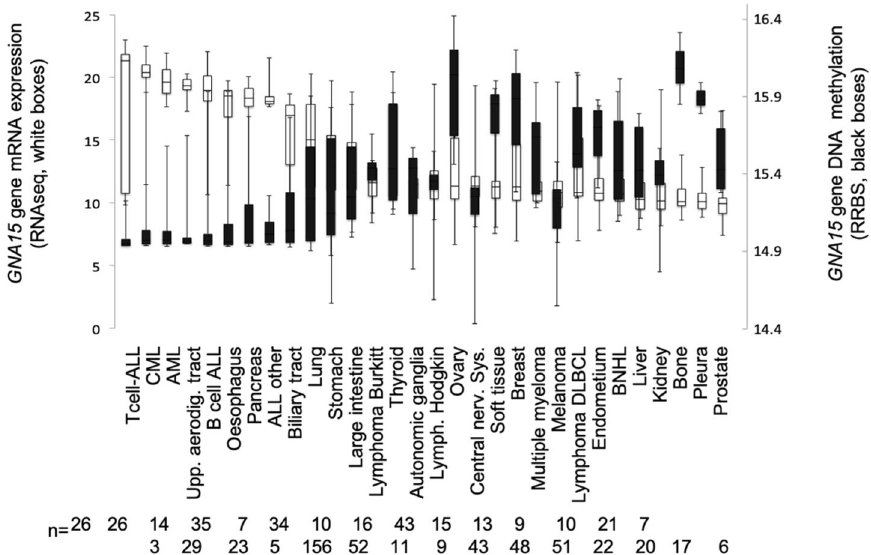
Figure 2. GNA15 expression and methylation in cancer cell lines. GNA15 mRNA expression (white bar showing RNAseq on the left axis) and DNA methylation (black bars, showing reduced representation bisulfite sequencing (RRBS) on the right axis) according to data from the Cancer Cell Encyclopedia. Among one thousand cancer cell lines, pancreas and biliary tract are the only normal tissues that do not express GNA15 but the derived cancer cell lines had high GNA15 expression levels, comparable to leukemia and upper aero- digestive tract. Box plots are shown as median and 25th and 75th percentiles. ALL acute lymphocytic leukemia, CML chronic myelocytic leukemia, AML acute myelocytic leukemia, DLBCL diffuse large B cell lymphoma, BNHL B cells non-Hodgkin lymphoma. The number below to the lineage name indicates how many cell lines are in the